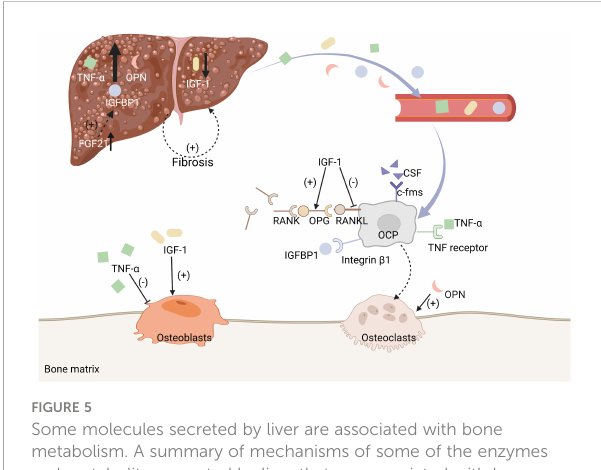
FIGURE 5 Some molecules secreted by liver are associated with bone metabolism. A summary of mechanisms of some of the enzymes and metabolites secreted by liver that are associated with